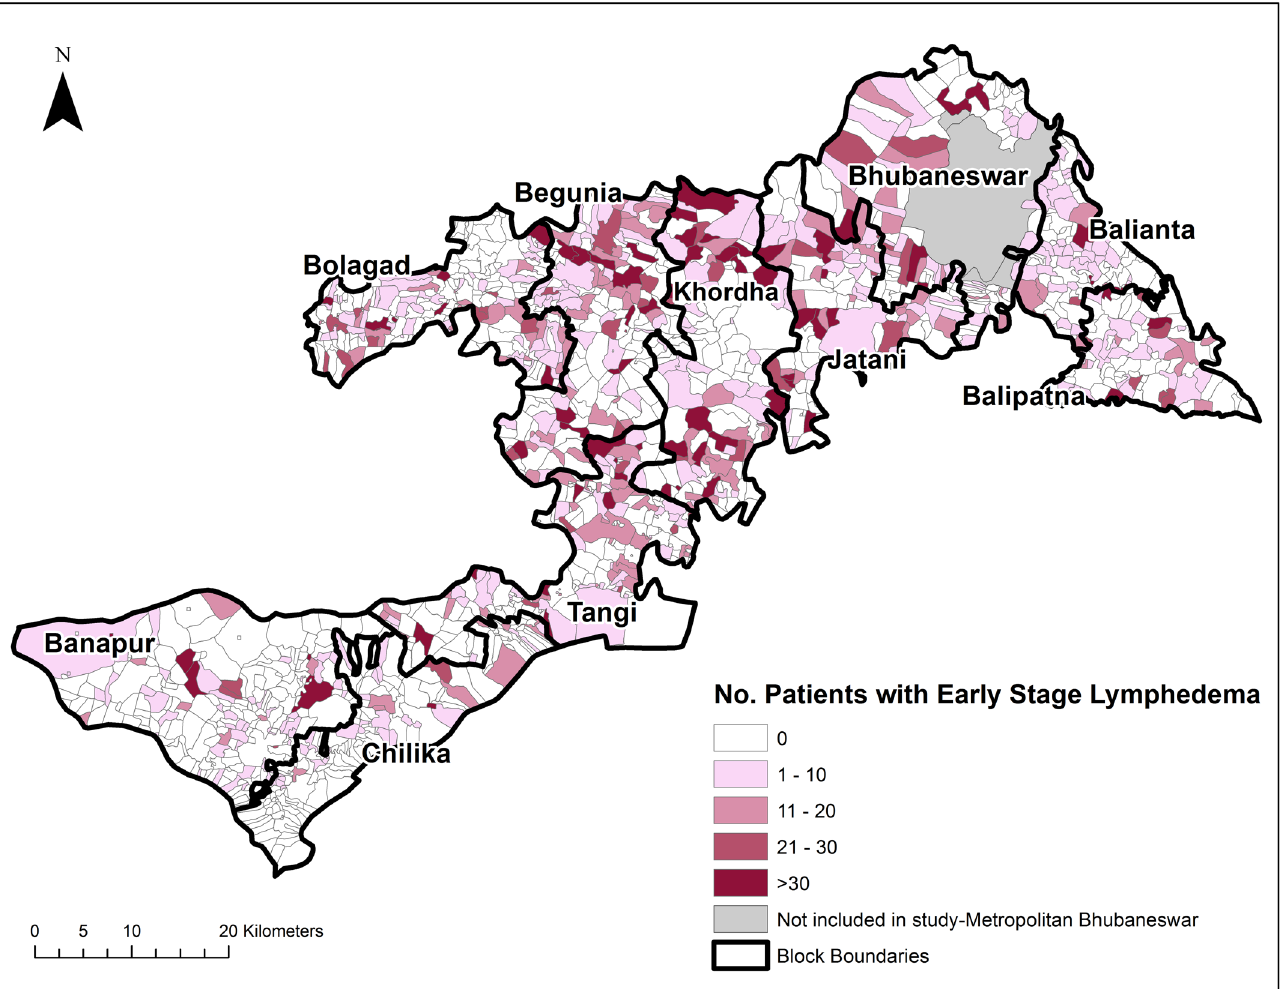
Fig 4. Early stage lymphedema patients by village in Khurda District, Odisha State, India. (Map generated in ArcGIS 10.2).